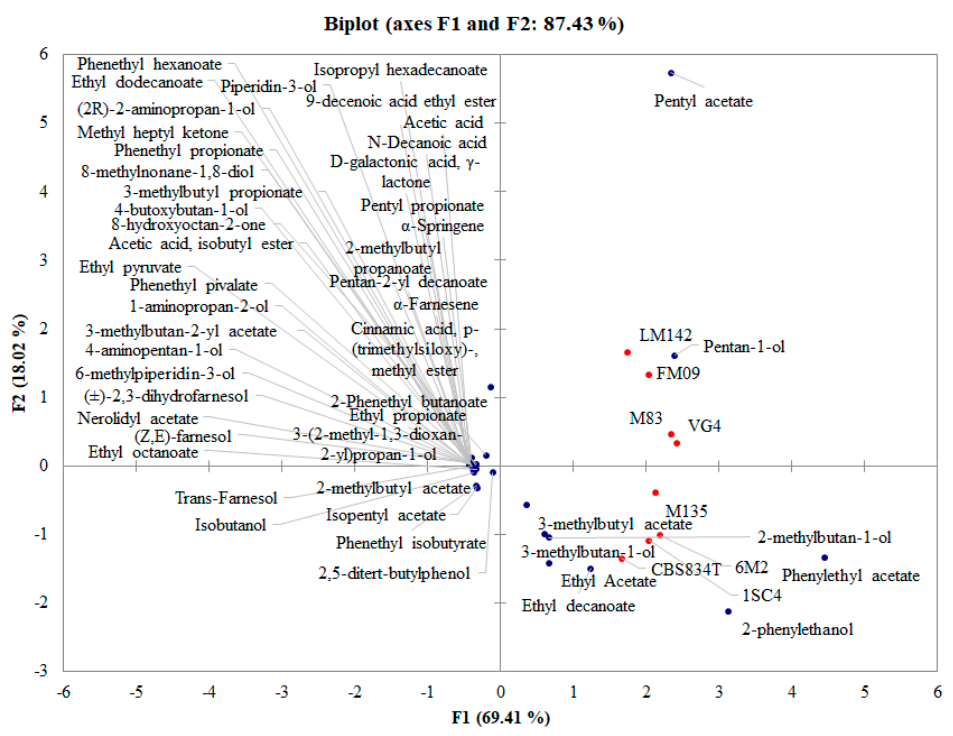
Figure 5. Principal component analysis (PCA) encompassing aroma compounds released by tested strains independently from the lifestyle.